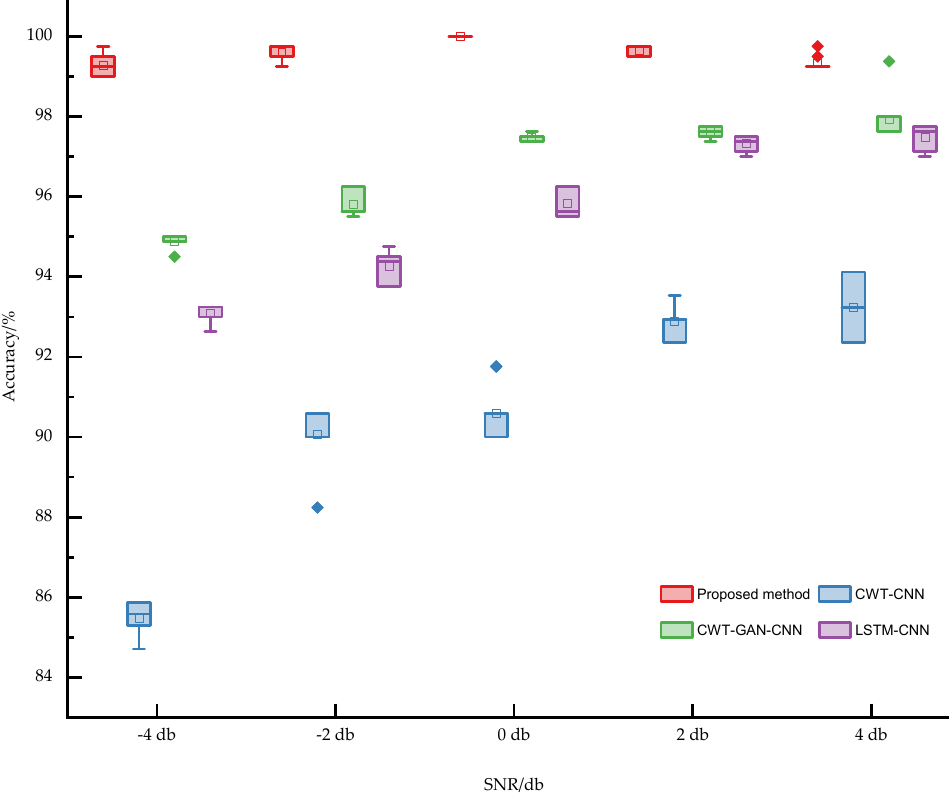
Table 5. Experiments for selection of optimal dropout using Dataset 1.